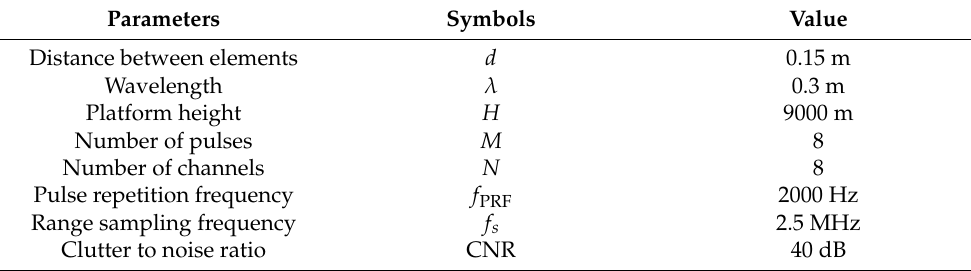
Table 2. Parameters of airborne radar